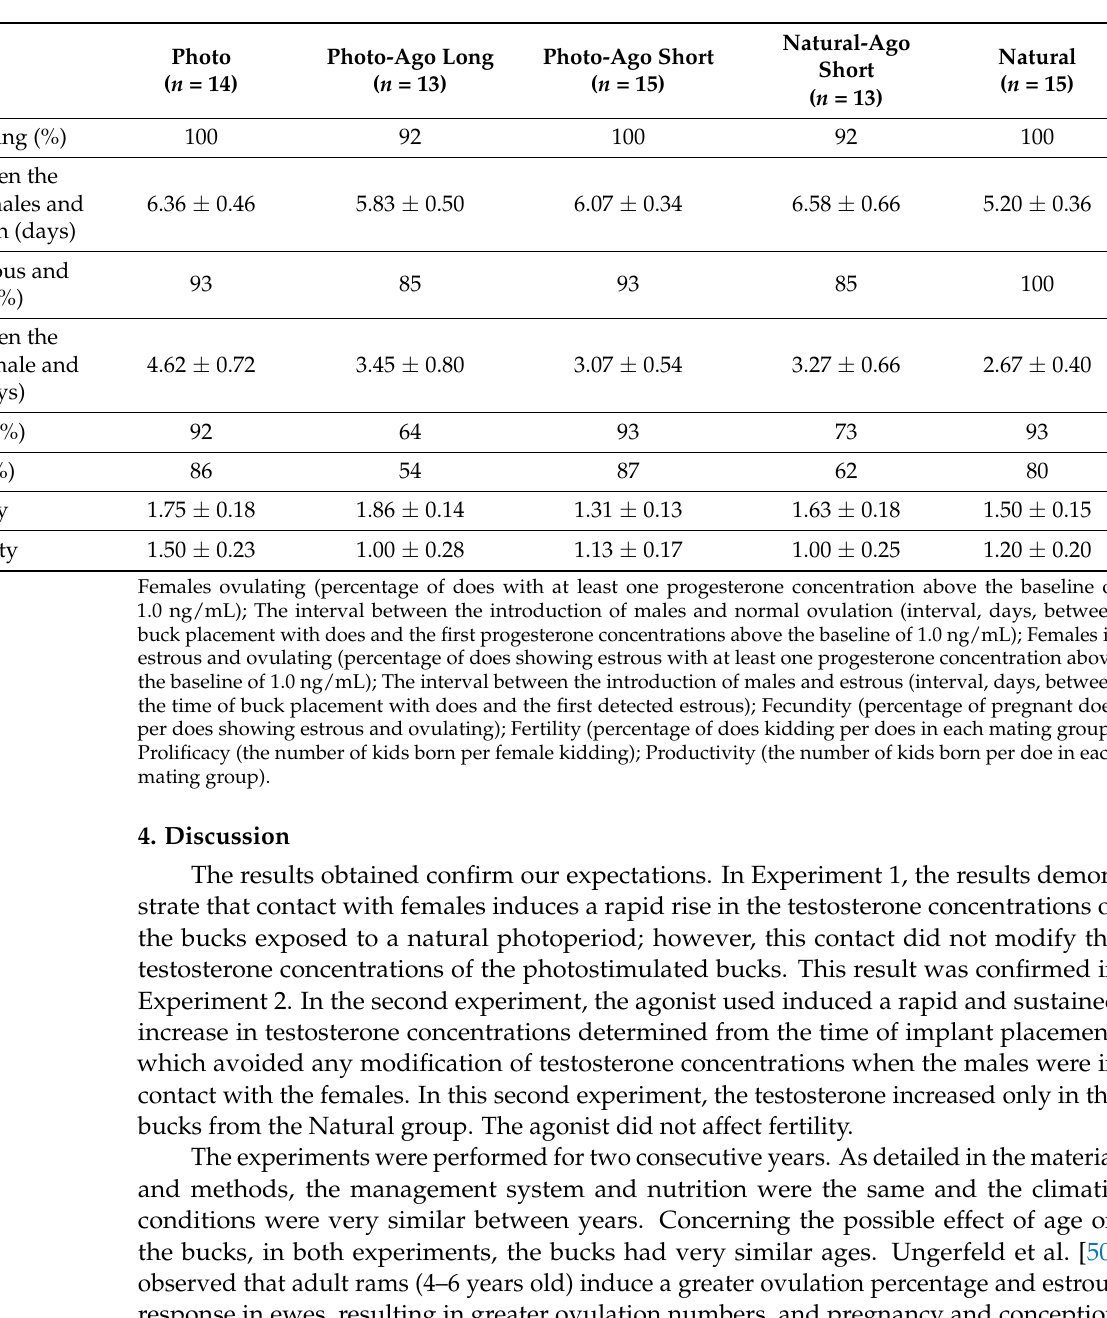
Table 2. (Experiment 2). The reproductive response of the females submitted to the male effect using photoperiod-treated males, i.e., long days for three months between November and February (Photo); males submitted to the same photoperiod treatment and a GnRH agonist at the onset of the photoperiod treatment (Photo-Ago Long); males submitted to the same photoperiod treatment and a GnRH agonist at the end of the photoperiod treatment (Photo-Ago Short); males subjected to the natural photoperiod and a GnRH agonist at the same time as the Photo-Ago Short (Natural-Ago Short) and males subjected to the natural photoperiod